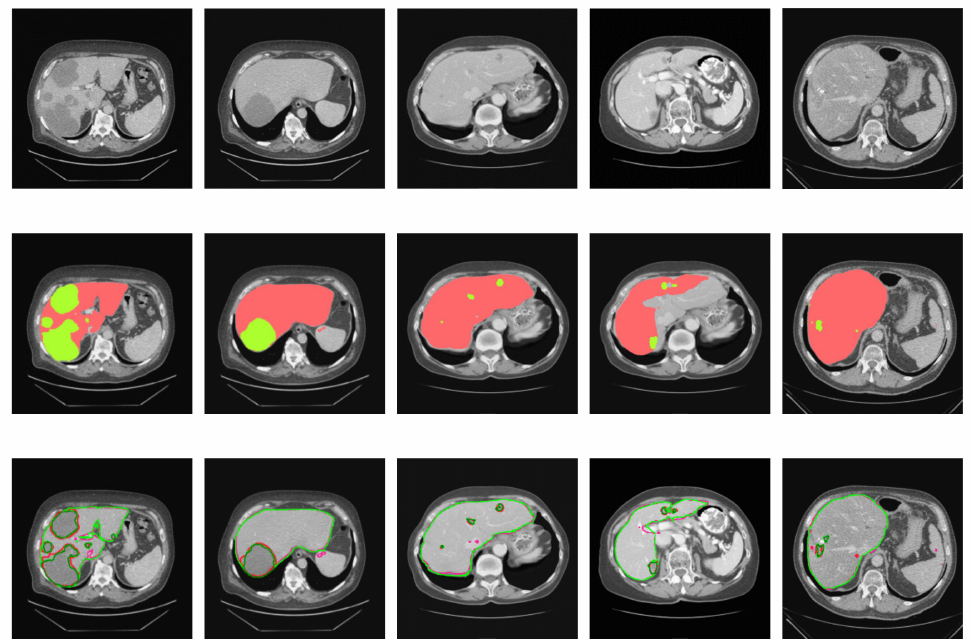
Figure 9. Typical segmentation results of the cascaded U-ADenseNet for the liver and